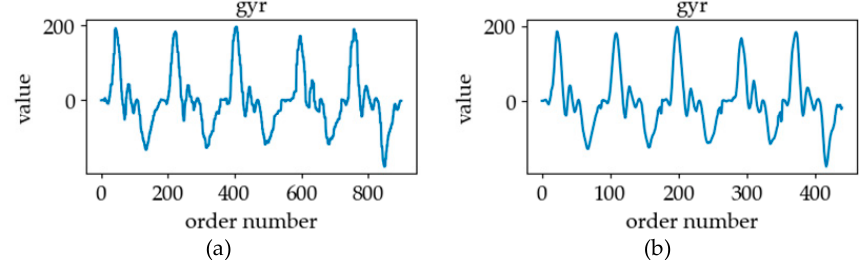
Figure 11. Smoothing of the GYR signal. ( a ) The original GYR signal and ( b ) the smoothed signal.